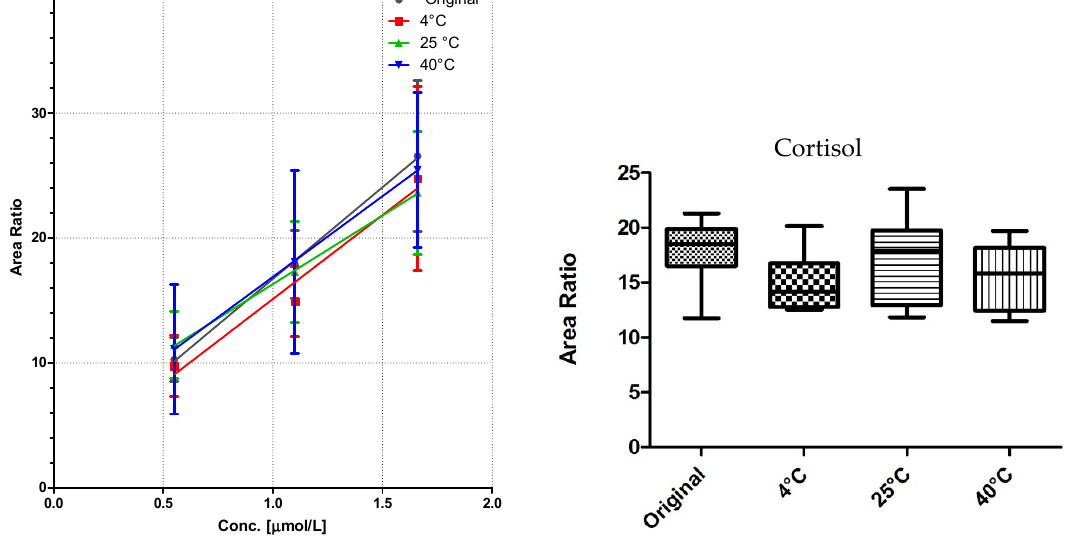
Figure 5. LC-MS/MS analysis of cortisol from DBS cards stored at different storage temperatures: ( left ) linearity (mean ± sd of n = 7); and ( right ) box and whiskers graph of level 2 with 5–95 percentiles of the same data.